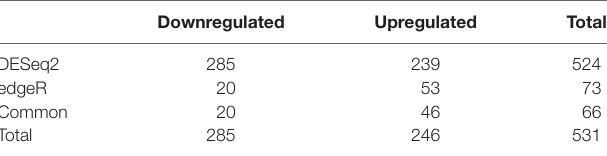
Table 5 | Differentially expressed genes.